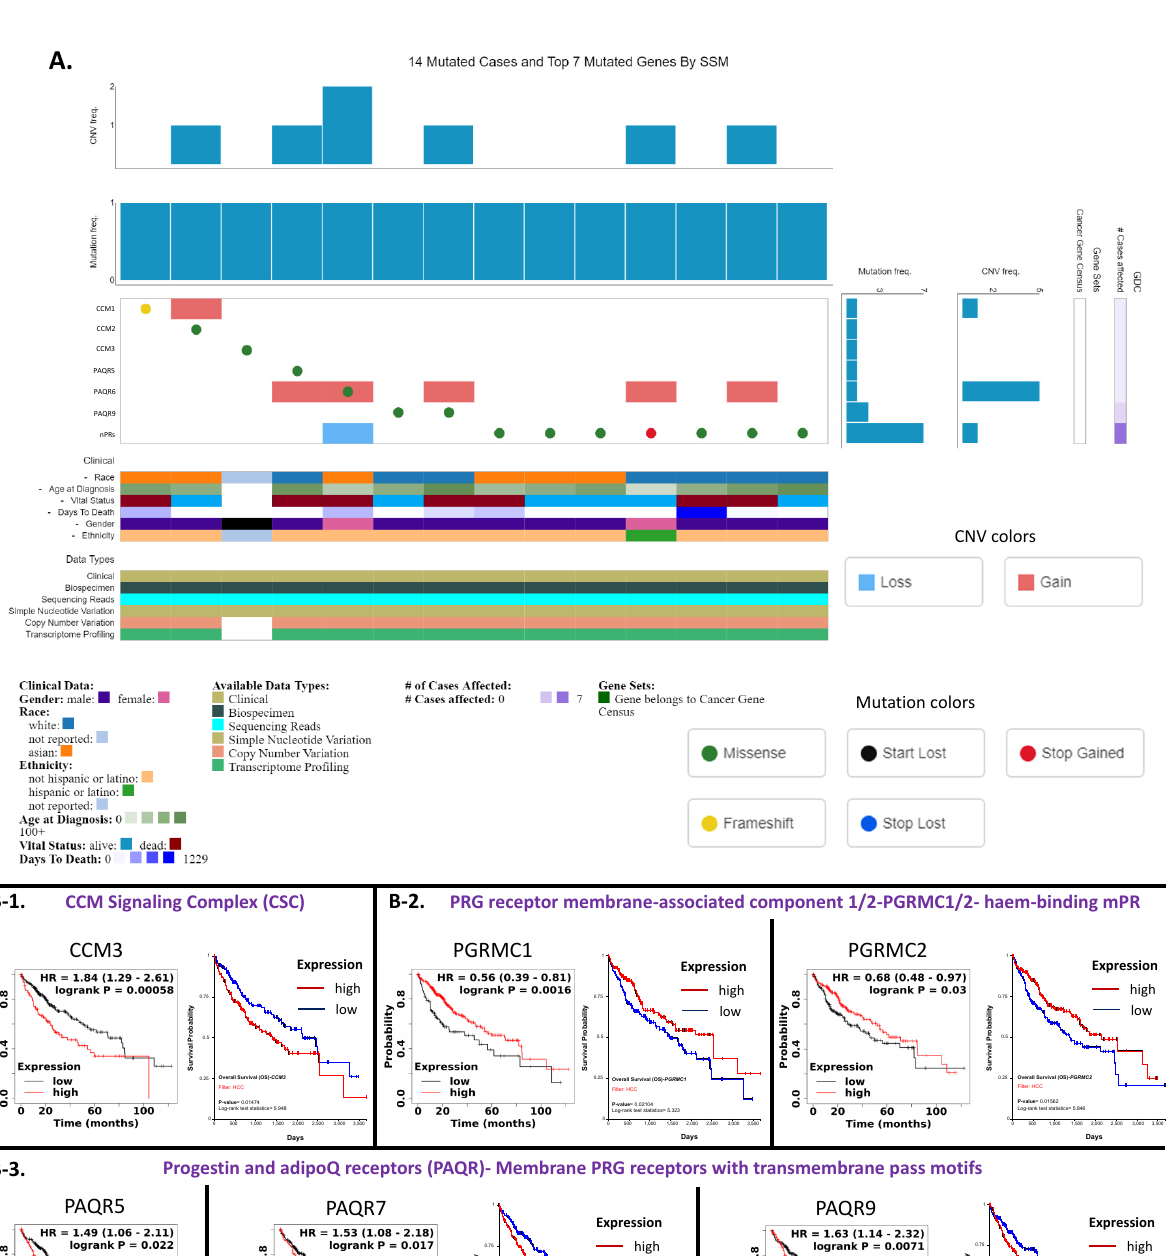
Progestin and adipoQ receptors (PAQR) ‐ Membrane PRG receptors with transmembrane pass motifs